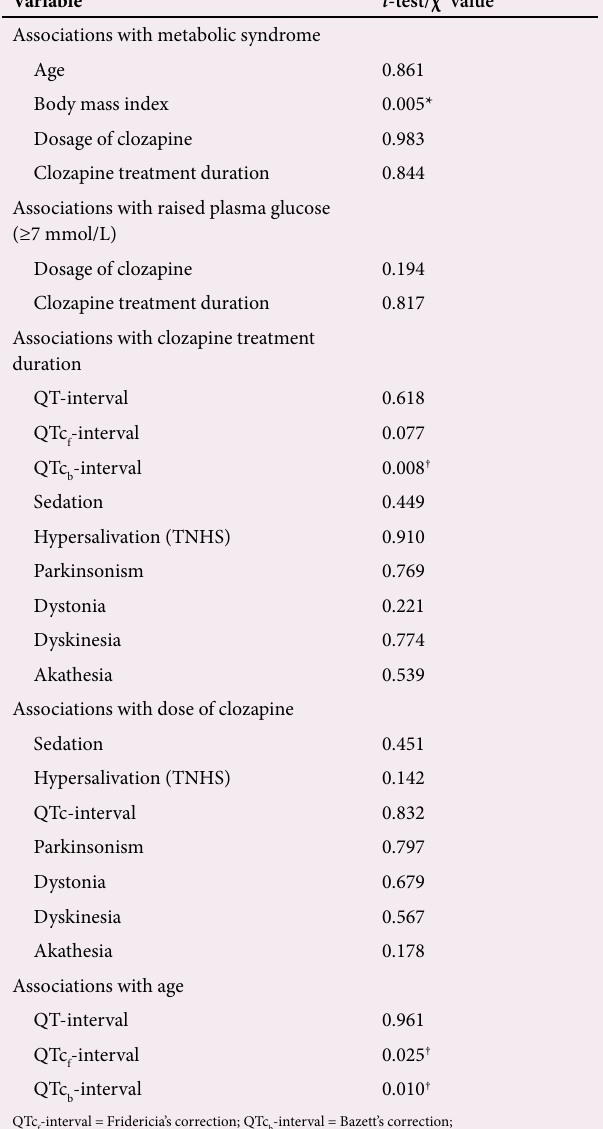
Table 2. Univariate associations with clozapine ( N =29) Variable